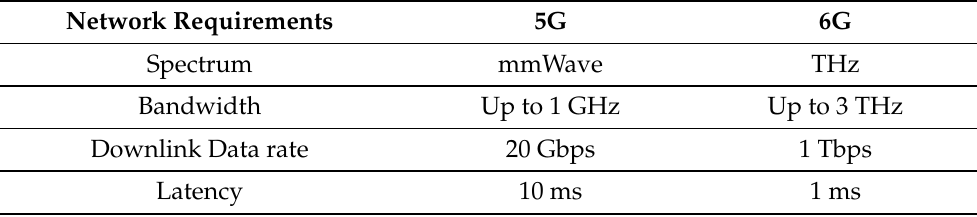
Table 1. 5G VS 6G network requirements expectations based on state-of-the-art research.